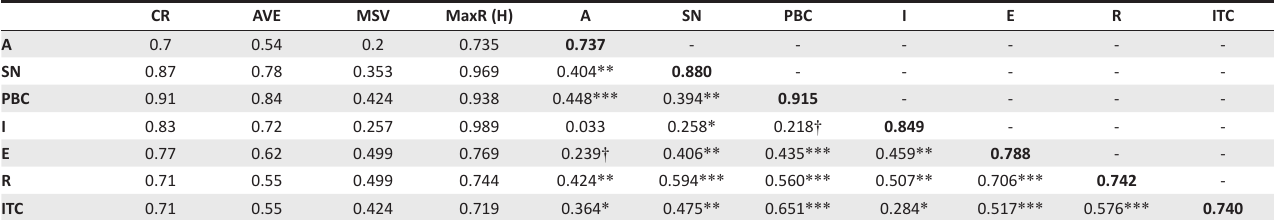
TABLE 1-A1: Validity and reliability measures.